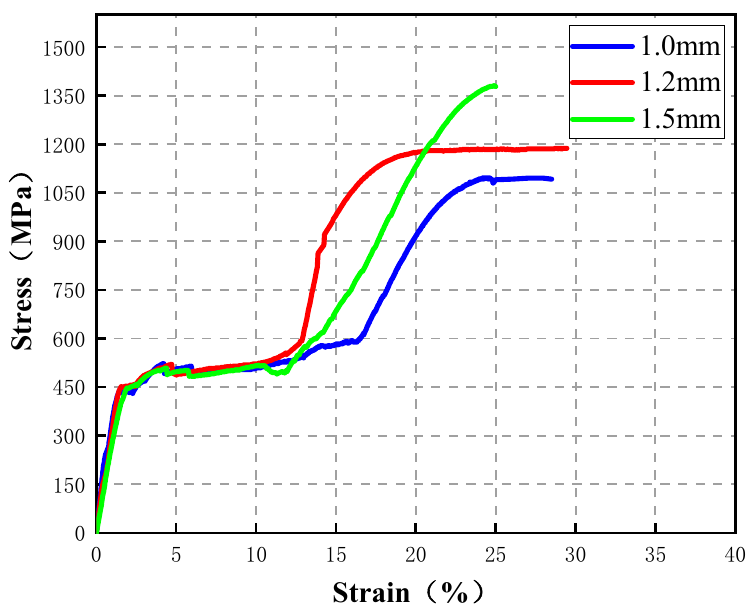
Figure 5. Direct tensile test stress–strain curves of SMA.